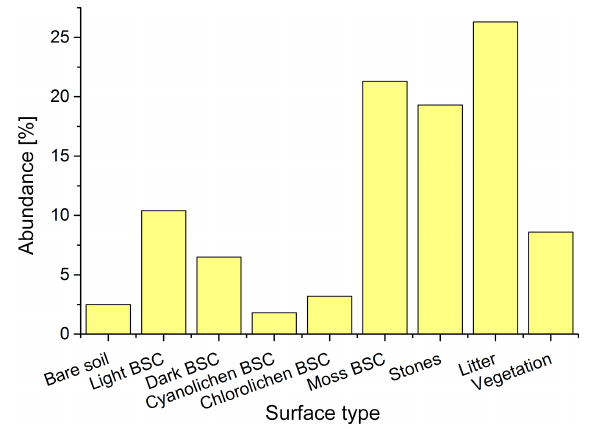
Figure 2. Distribution of different types of ground surfaces in the studied area. Information derived from 50